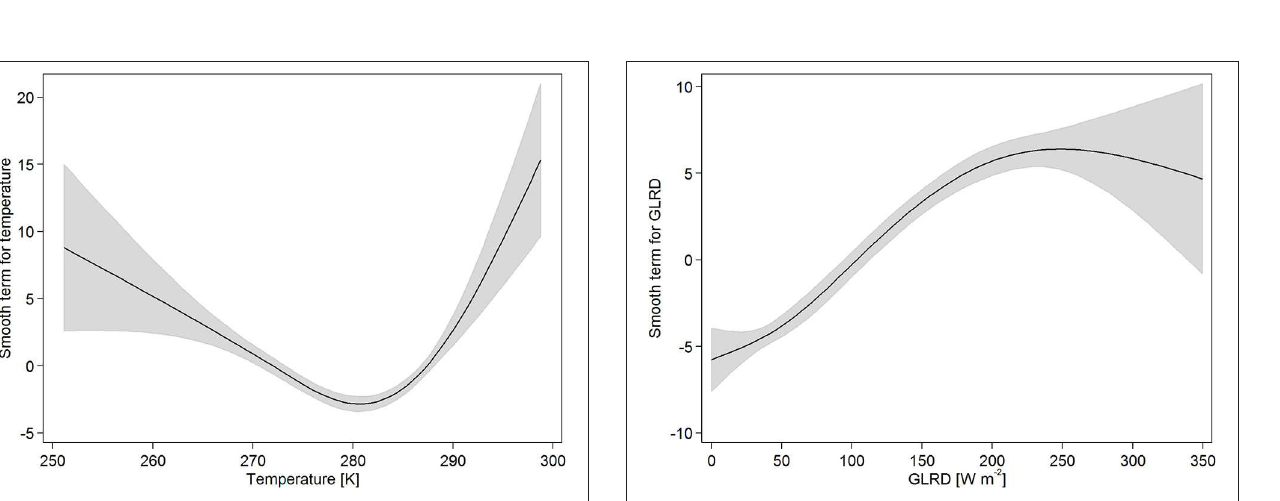
FIGURE 4 | Effect of air temperature upon expected ambient O 3 concentration, BKR site.